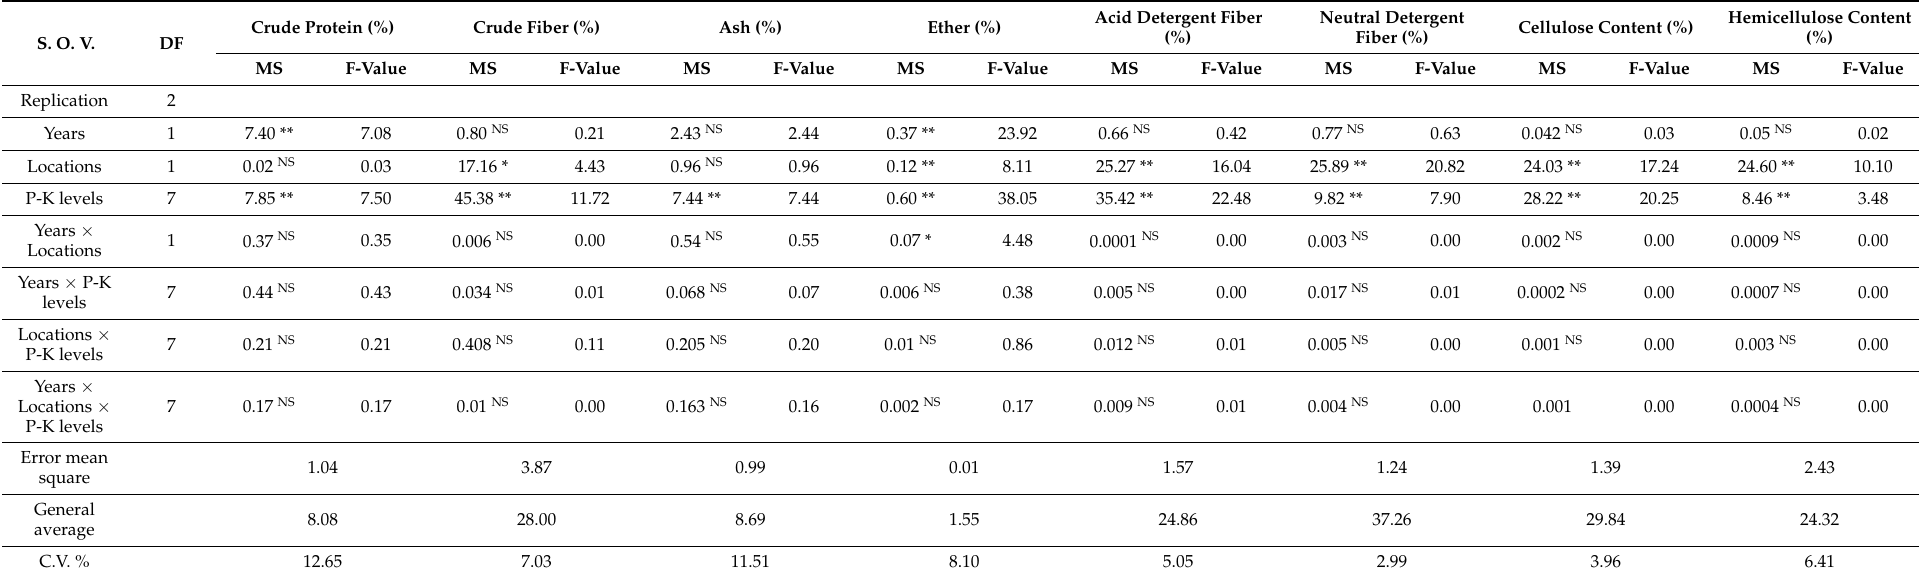
Table 5. ANOVA table of fodder quality traits of sorghum during both years and